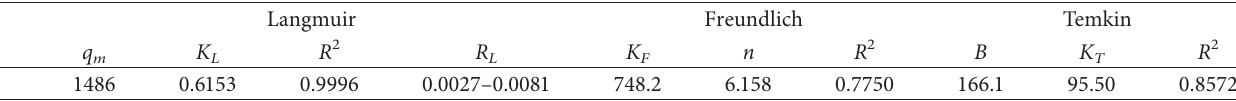
Table 5: Adsorption isotherm parameters. Langmuir Freundlich